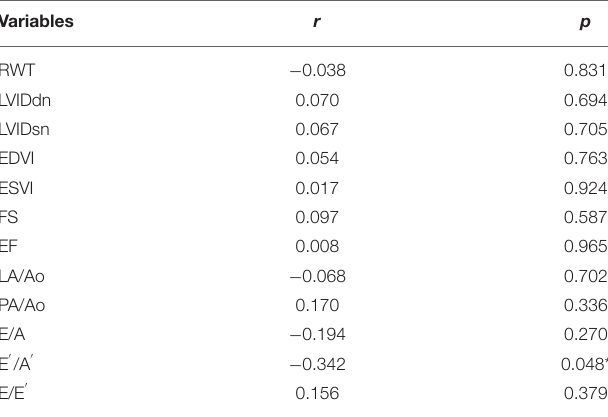
TABLE 3 | Bivariate correlation analysis of the conventional echocardiographic indices with galectin-3 concentration.